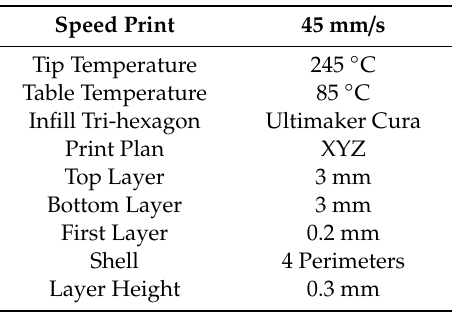
Table 1. Printing parameters used.